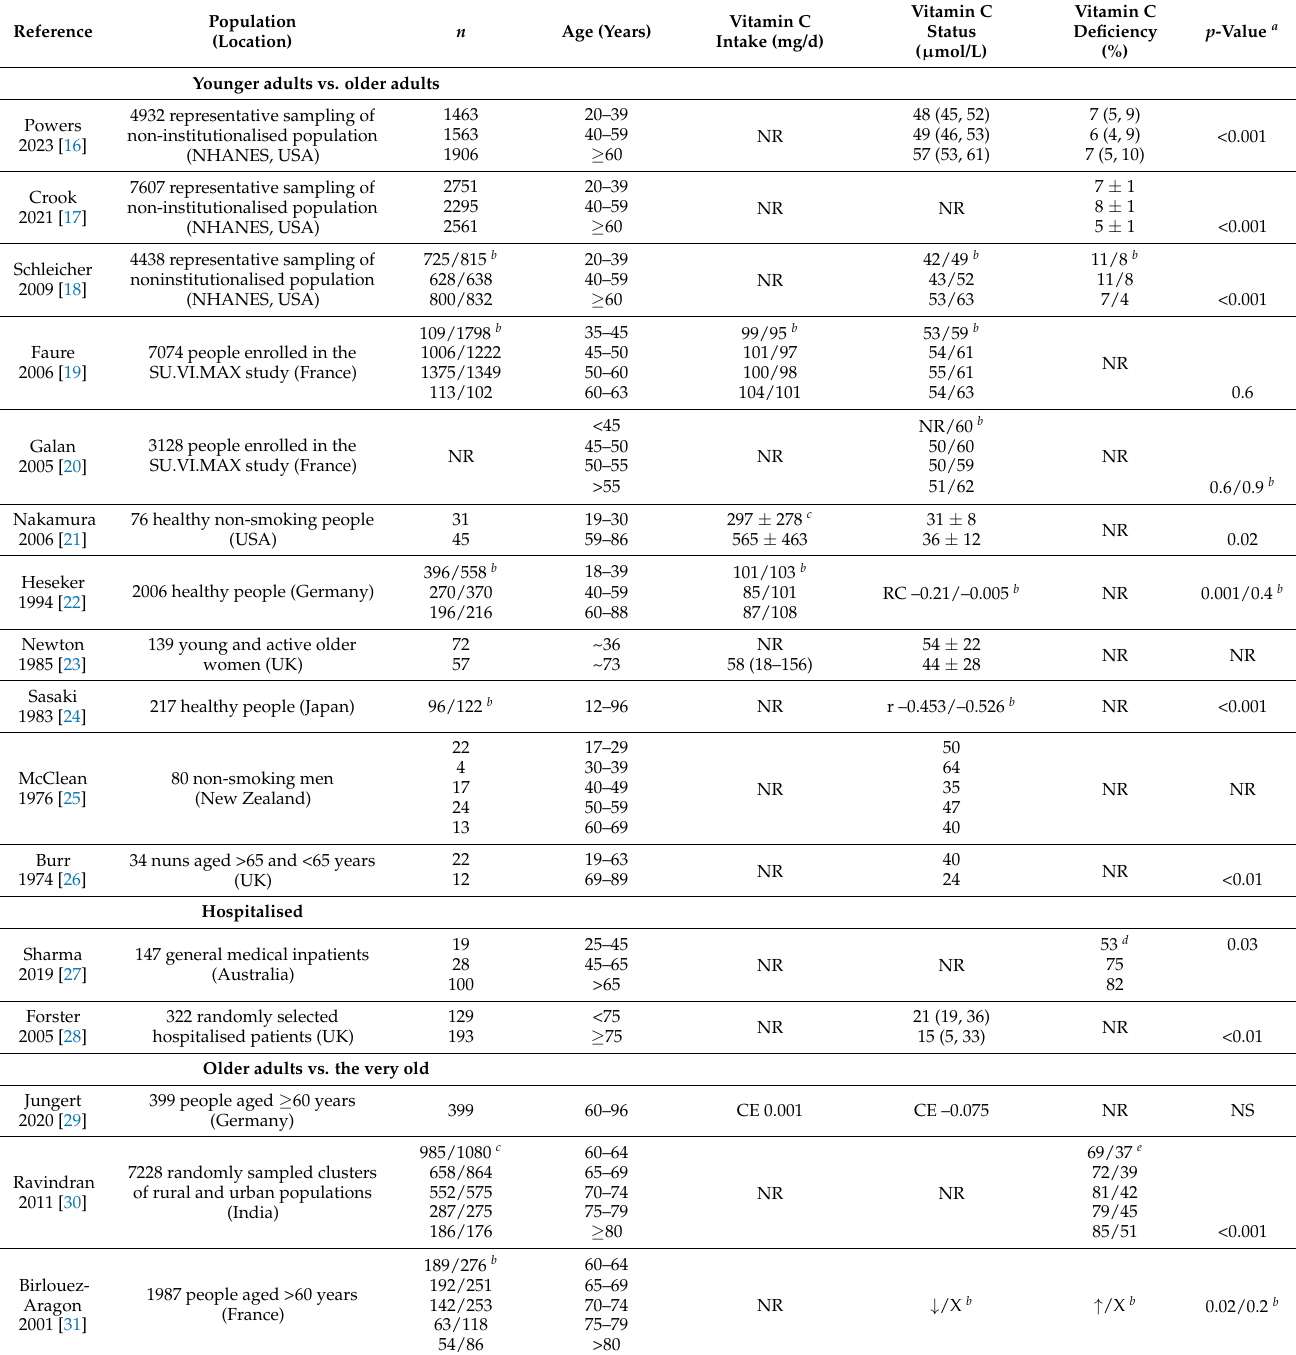
Table 1. Vitamin C status relative to